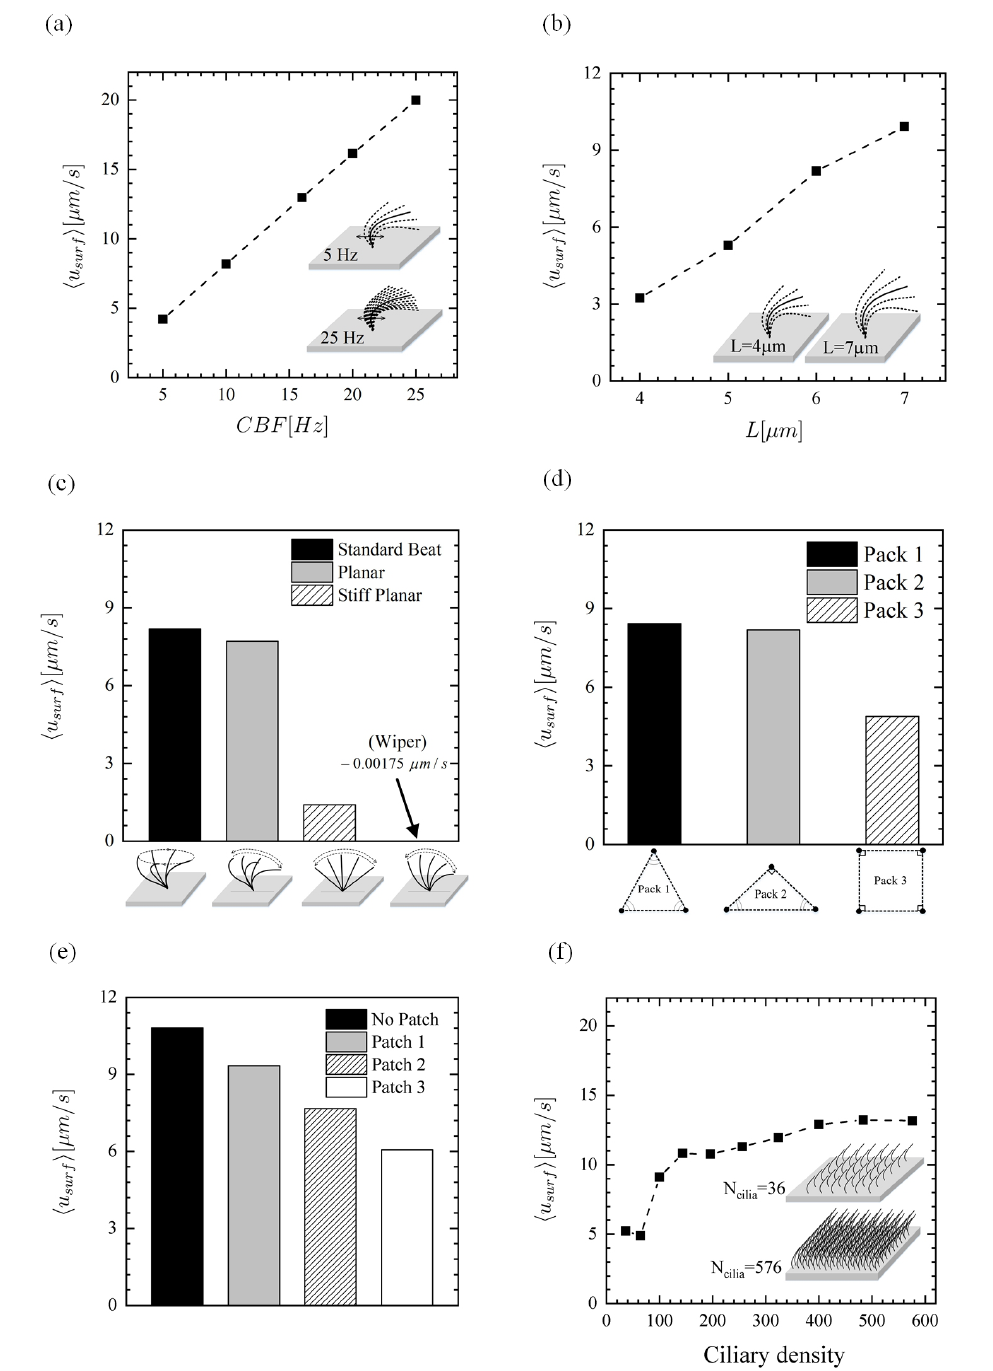
Figure 10. Time-averaged surface mean velocity. Effect of ( a ) beat frequency, ( b ) length of cilia, ( c ) ciliary beat pattern, ( d ) ciliary pack, ( e ) missing ciliary patch, and ( f ) ciliary density (number of cilia over the ciliated